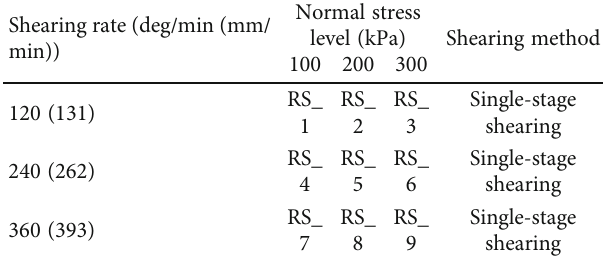
, D , and D are the particle sizes corresponding to 10%, 30%, and 60% fi ner materials 10 30 60 Table 2: Ring shear test program of the loess samples.